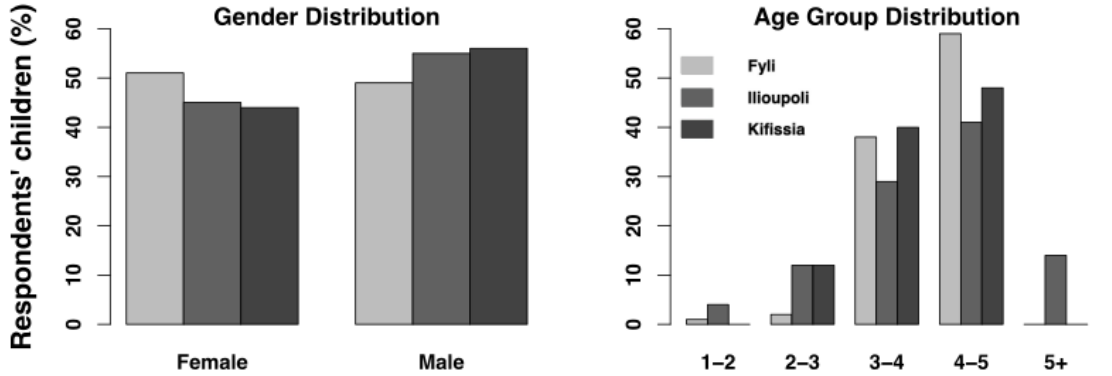
Figure 2 Demographic characteristics of responden ts’ children